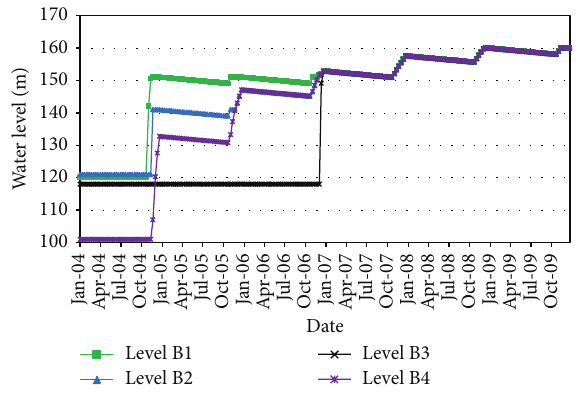
Figure 8: Water level time series for the validity test.